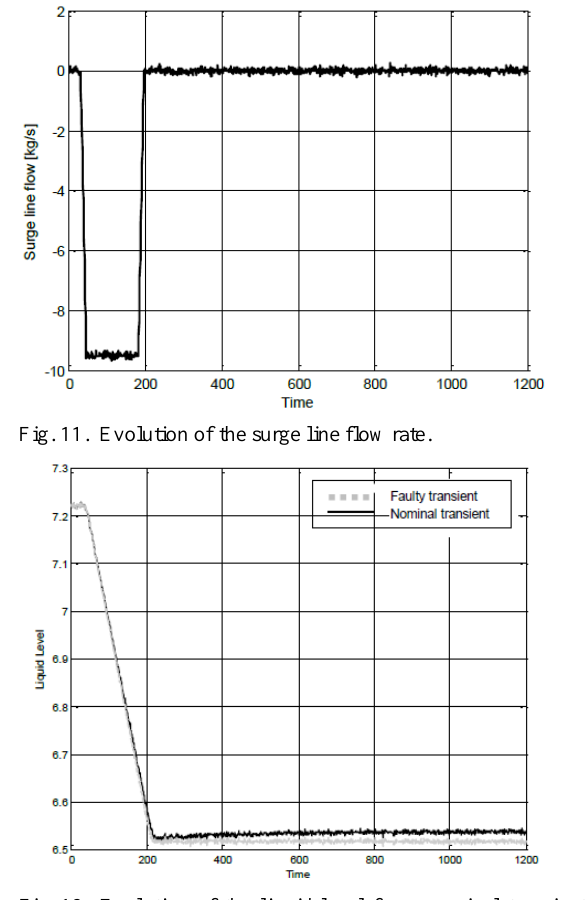
Fig. 12. Evolution of the liquid level for a nominal transient and the faulty